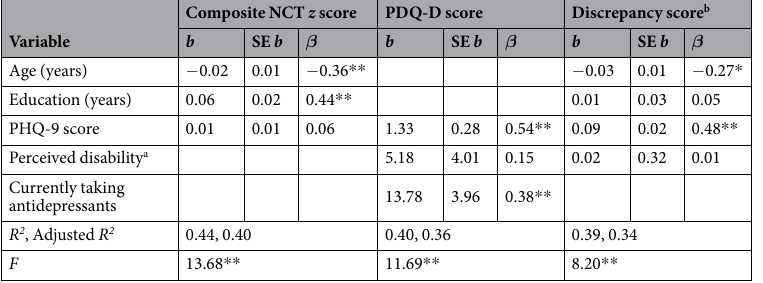
Table 4. Summary of multiple regression analyses for variables predicting PDQ-D total and composite z scores (N = 57). * p < .05, ** p < 0.01. a ≥ 1 SDS subscale ≥ 5 points. b Composite NCT z score subtracted by corresponding reversed PDQ-D z